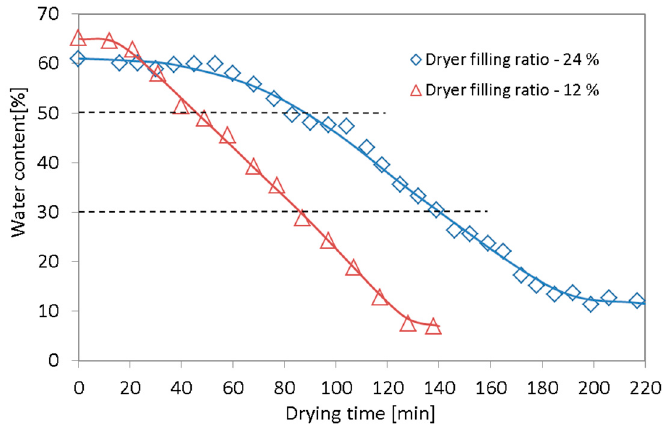
Figure 7. Drying curves of green wood chips for various dryer fillings and the conditions in Table 3.